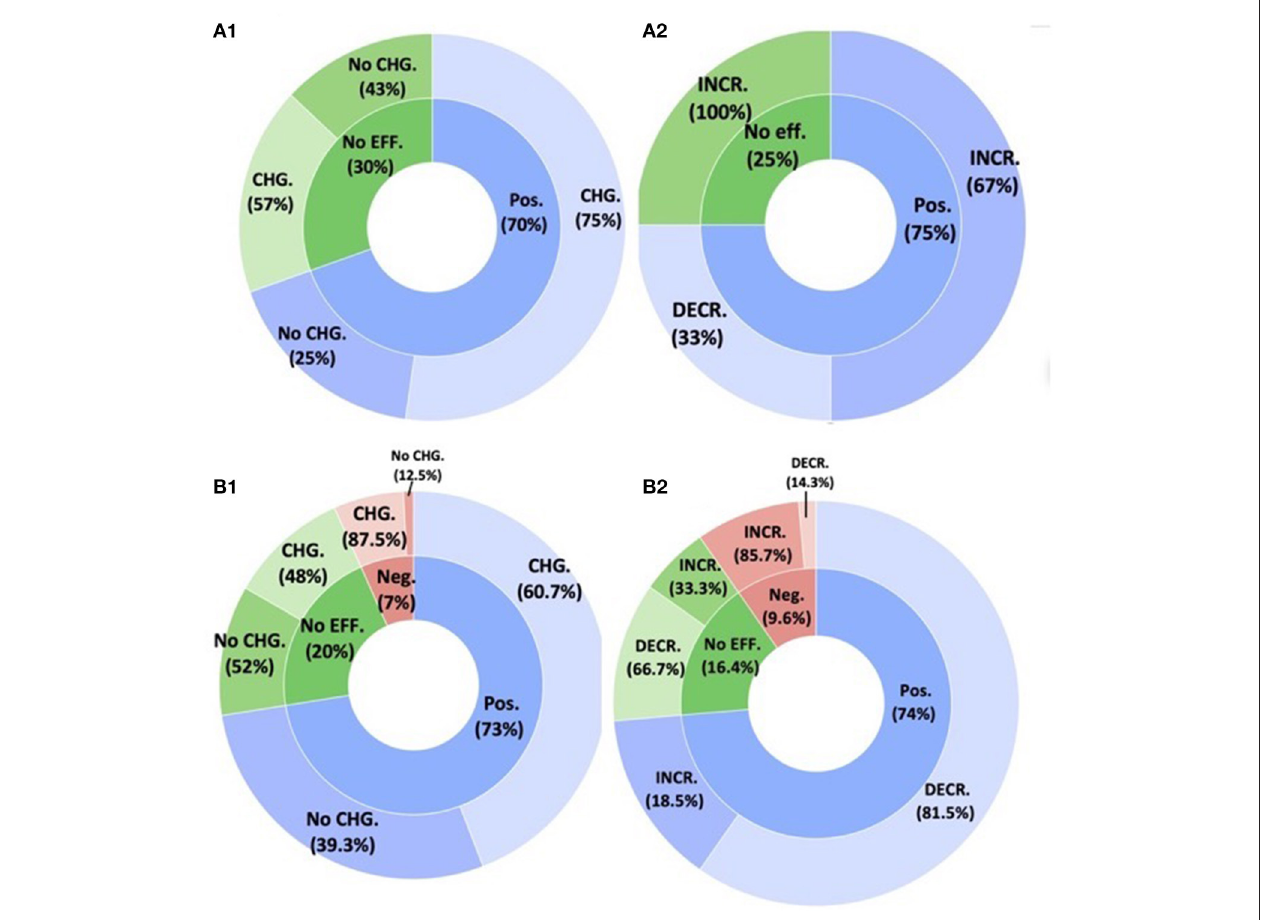
FIGURE 7 | The effect of the native (A) fungal and (B) bacterial community changes in plant performance post inoculation. (A1,B1) The inner rings demonstrate plant response (positive, negative, or no response). The outer rings demonstrate the proportion of studies that showed SMC changes following inoculation (A1) resident fungal and (B1) resident bacterial community. (A2,B2) Boxed pie charts demonstrate the directional community changes (increased vs. decline) per environment category (microcosm, field, or greenhouse) for the studies that showed SMC changes following